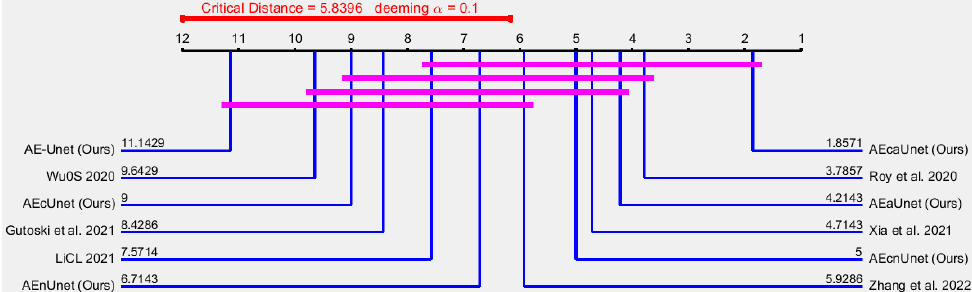
Figure 21. Nemenyi [141] post hoc critical distance diagram for α = 0.10 using fAUC scores in Table 10 for G 5